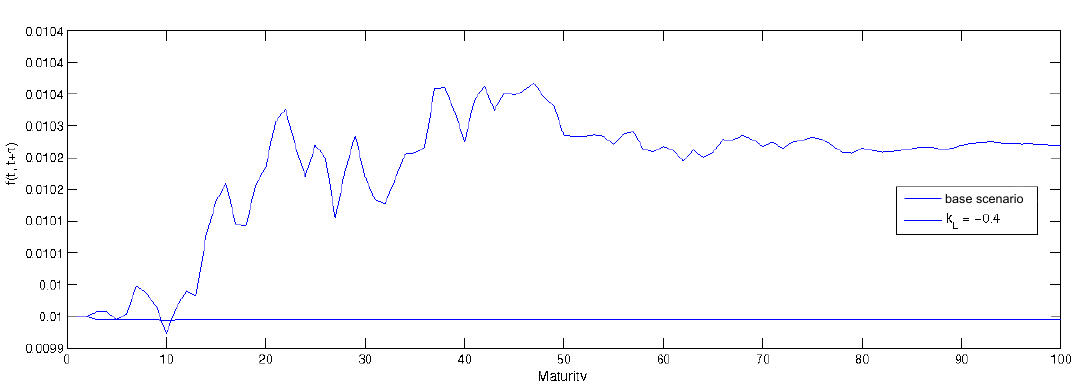
Figure 12. Forward instantaneous rate to varying parameters k z , k η , and k L .